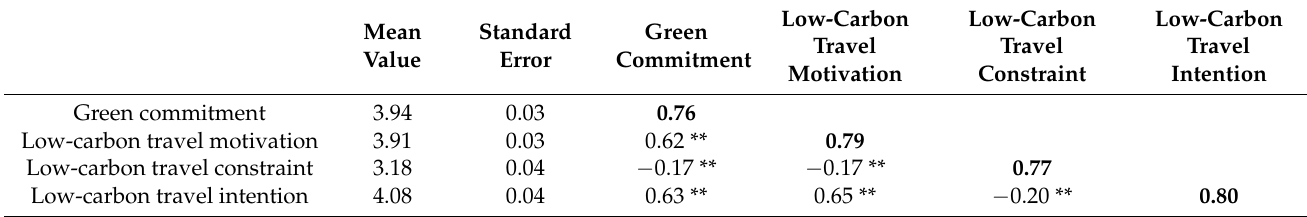
Table 2. Correlation coefficient matrix ( n = 358).